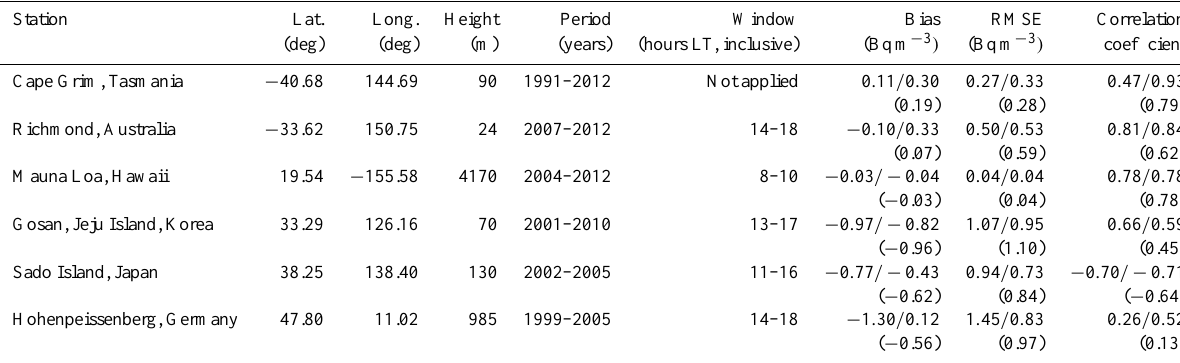
Table A2. List of stations used for the evaluation of the simulated surface radon-222 concentrations. The mean bias and root mean square errors (RMSE) in the simulated monthly mean concentrations are indicated for the online and offline EC-Earth simulations and the ERA- Interim simulation. Also given are the linear correlation coefficients between the simulated and measured monthly mean concentrations. A diurnal window has been applied to the measurements, except for Cape Grim. The results for the online EC-Earth simulation and the ERA-Interim simulation are separated by a slash; the results for the offline EC-Earth simulation are shown between parentheses.